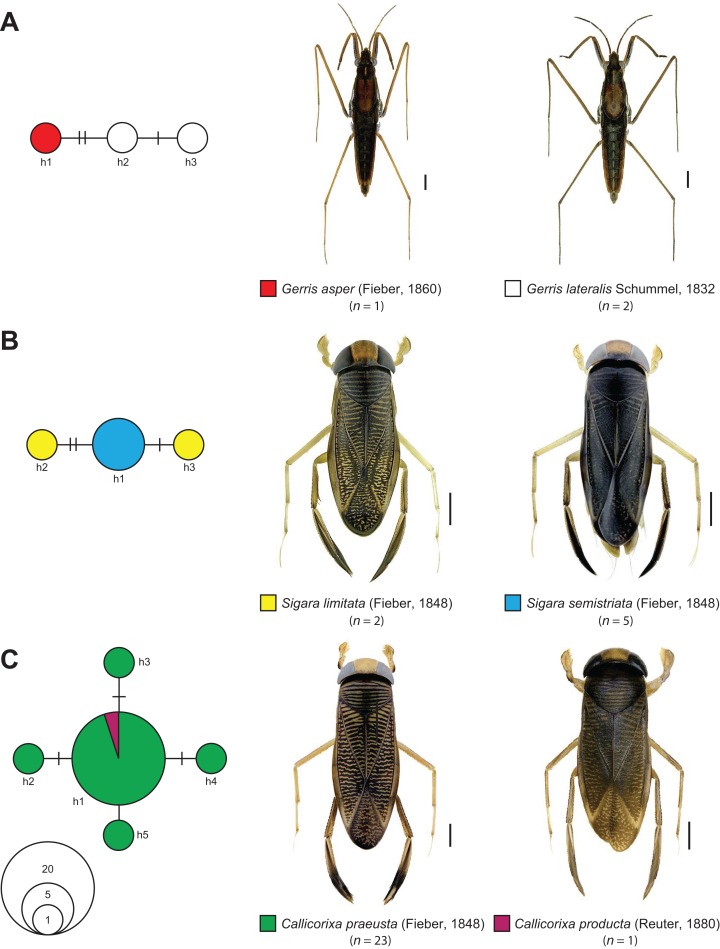
Maximum statistical parsimony network of various species of the Gerromorpha and Nepomorpha with interspecific K2P-based distances of COI sequences <1%.(A) Gerris asper (Fieber, 1860) (n = 1) and Gerris lateralis Schummel, 1832 (n = 2); (B) Sigara limitata (Fieber, 1848) (n = 2) and Sigara semistriata (Fieber, 1848) (n = 5); (C) Callicorixa praeusta (Fieber, 1848) (n = 23) and Callicorixa producta (Reuter, 1880) (n = 1). Used settings included default settings for connection steps whereas gaps were treated as fifth state. Each line represents a single mutational change whereas small black dots and small black lines indicate missing haplotypes. The diameter of the circles is proportional to the number of haplotypes sampled (see open half circles with numbers). Color codes were given for each species. Scale bars = 1 mm. Aquatic bug images were obtained from http://www.corisa.de.